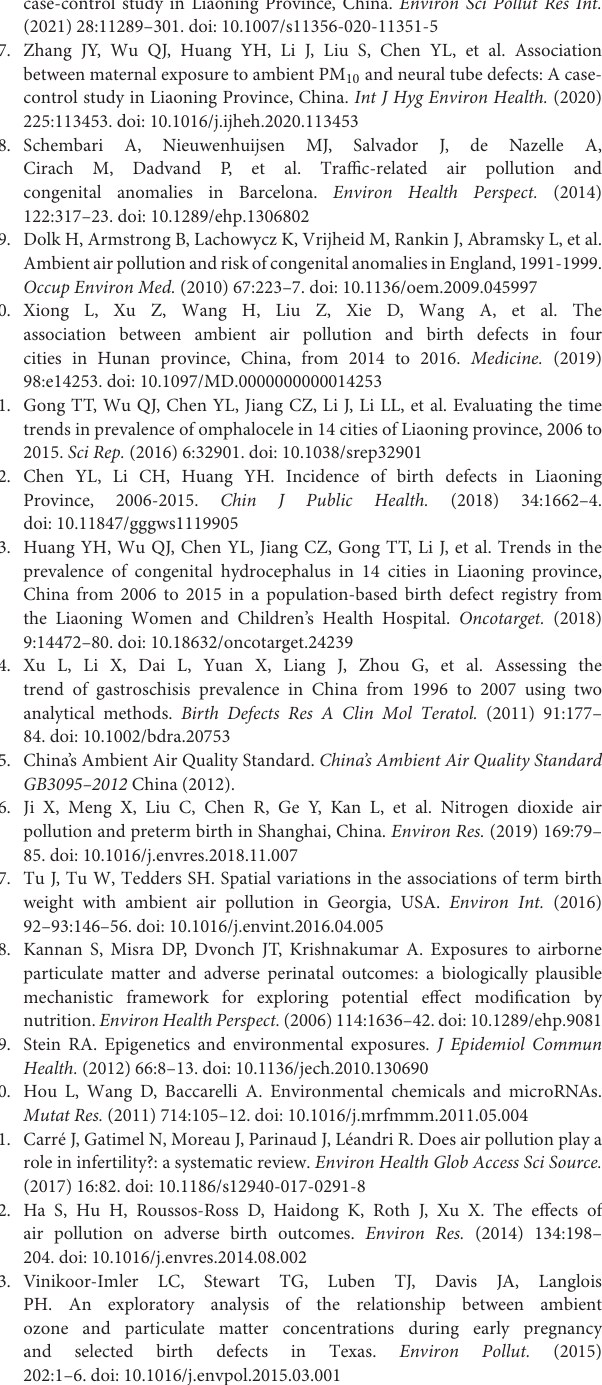
Supplementary Table 1 | The maternal age stratification (<30, ≥ 30 years) subgroups were analyzed for the associations between ambient SO 2 exposure( µ g/m 3 ) with controls and